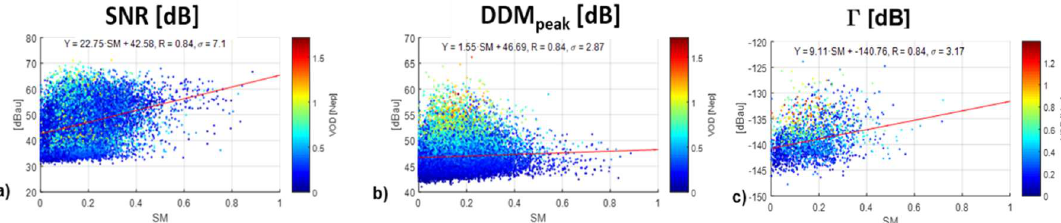
Figure 11. Screened and compensated TDS-1 GNSS-R observables vs. SMOS SM data: ( a ) SNR [dB], ( b ) DDM peak [dB], ( c ) Г [dB] over θ i ≤ 30°.